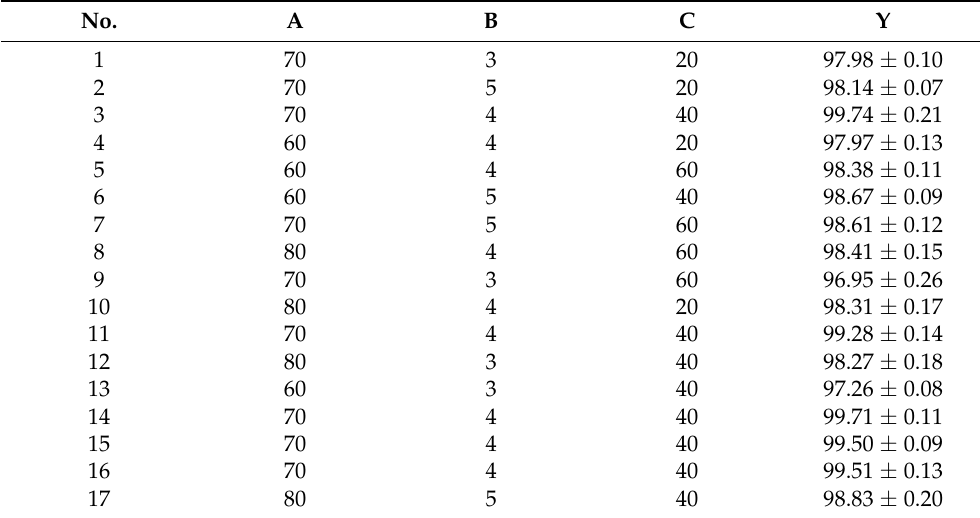
Table 2. Experimental design and data for the extraction rate of naringin from the CCD. No.